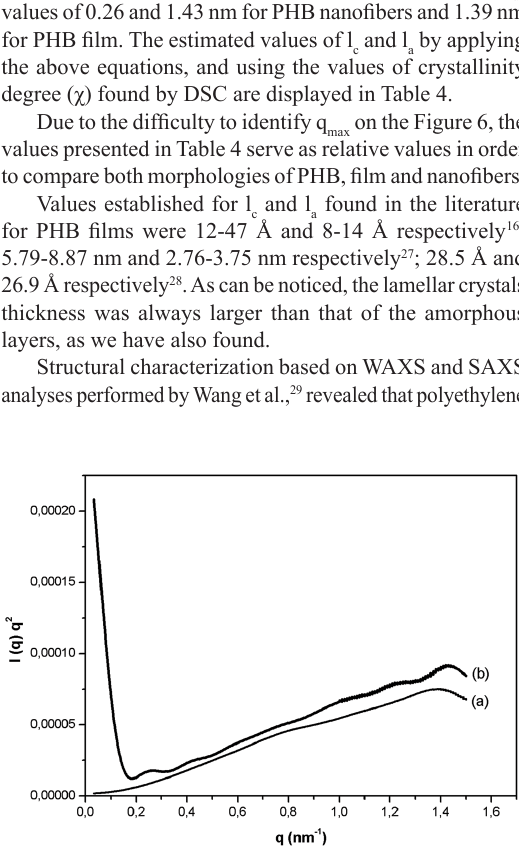
Figure 6. Lorentz corrected SAXS profiles of: (a) PHB thermo- compression molded film and (b) PHB nanofibers mat.